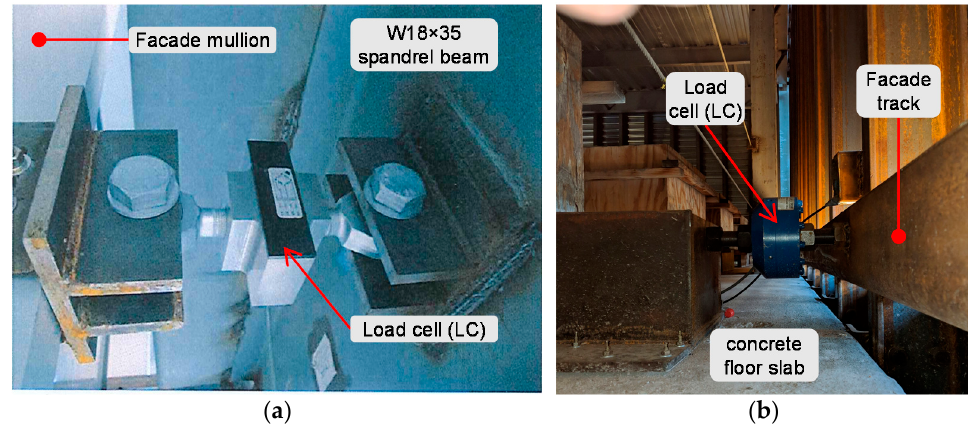
Figure 9. Close ‐ up views of load cell configuration to measure the dynamic reaction loads trans ‐ Figure 9. Close-up views of load cell configuration to measure the dynamic reaction loads transferred ferred from the façade to the steel frame: ( a ) Test 1 LC connecting the mullion ‐ to ‐ spandrel beam from the façade to the steel frame: ( a ) Test 1 LC connecting the mullion-to-spandrel beam web; web; ( b ) Test 2 LC connecting façade track ‐ to ‐ slab (refer to Figures 4a and 5a for LC locations). ( b ) Test 2 LC connecting façade track-to-slab (refer to Figures 4a and 5a for LC